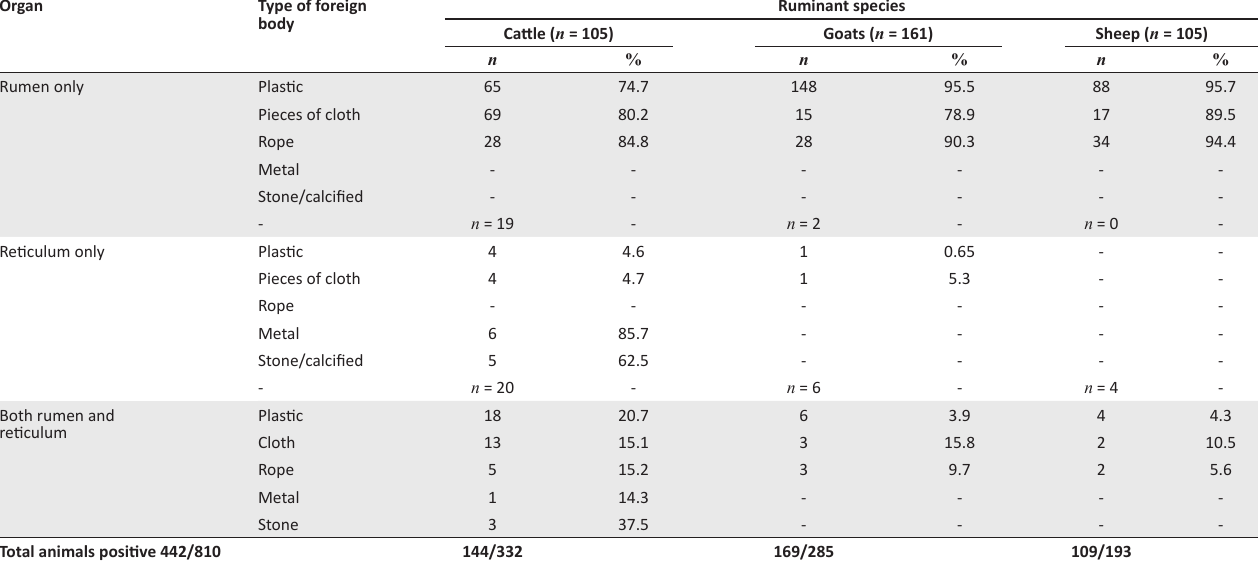
TABLE 3: Types and proportions of foreign bodies in the rumen and reticulum of ruminant species. Organ